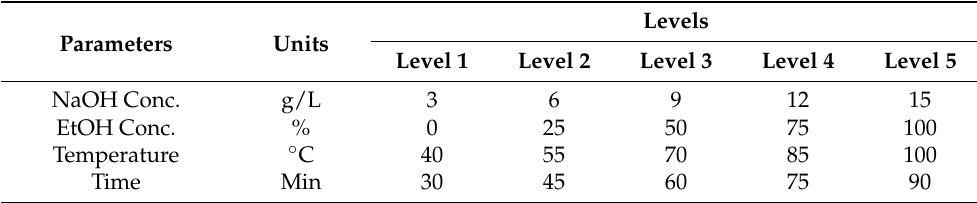
Table 3. Extraction parameters and their levels.